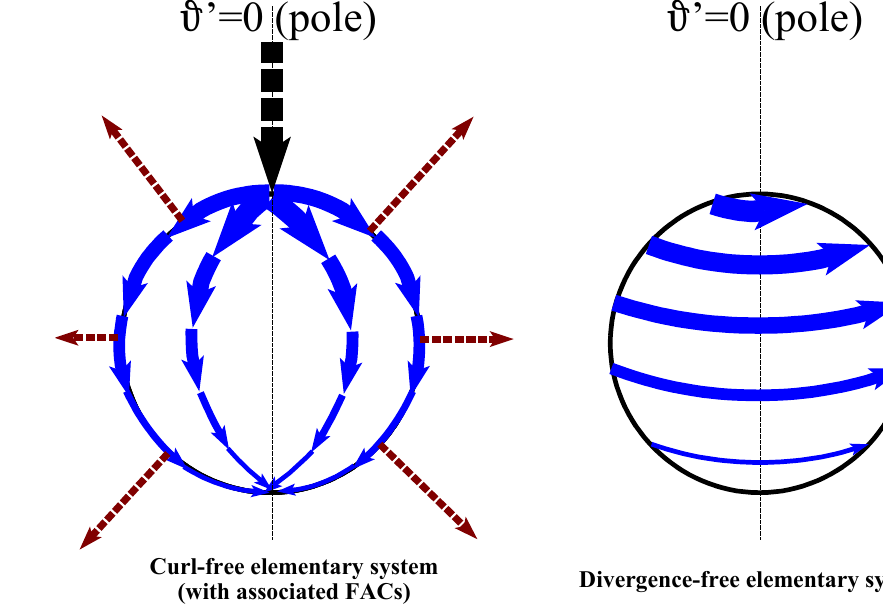
Fig. 2. Spherical elementary current systems